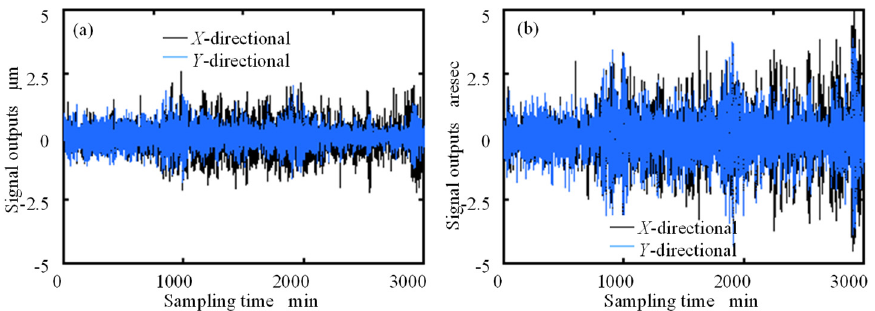
Figure 11. Outputs of ( a ) QD5 and ( b ) QD6 when the IAEC was activated with the traditional PID controller.